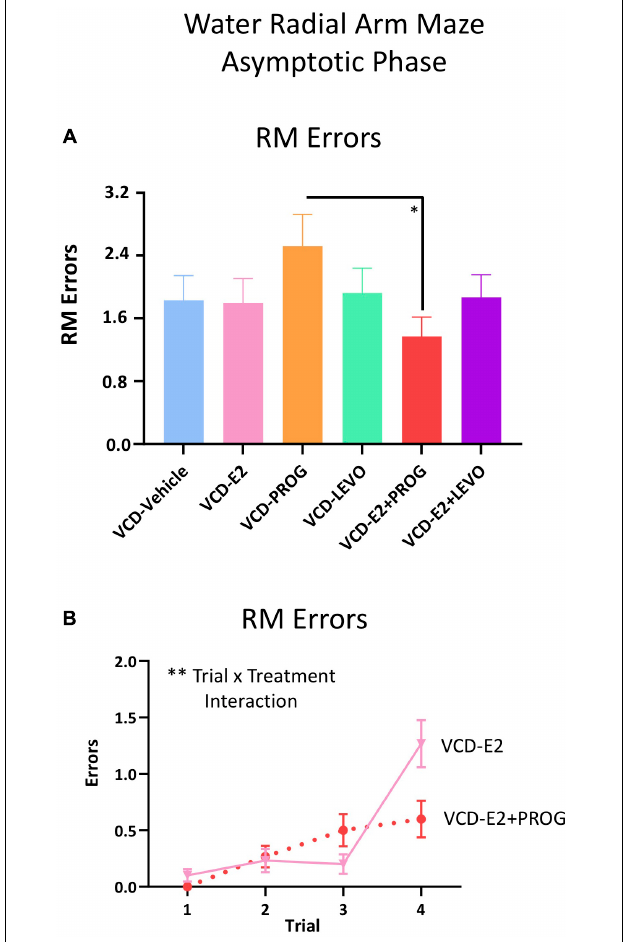
FIGURE 6 | RM Errors During the Asymptotic Phase. (A) Across all trials, a main effect of Treatment was present between the VCD-PROG group and the VCD-E2 + PROG group ( p < 0.05). (B) VCD-E2 vs. VCD-E2 + PROG comparison: A Trial × Treatment interaction occurred ( p < 0.01). Significance: ∗ = p < 0.05, ∗∗ = p <